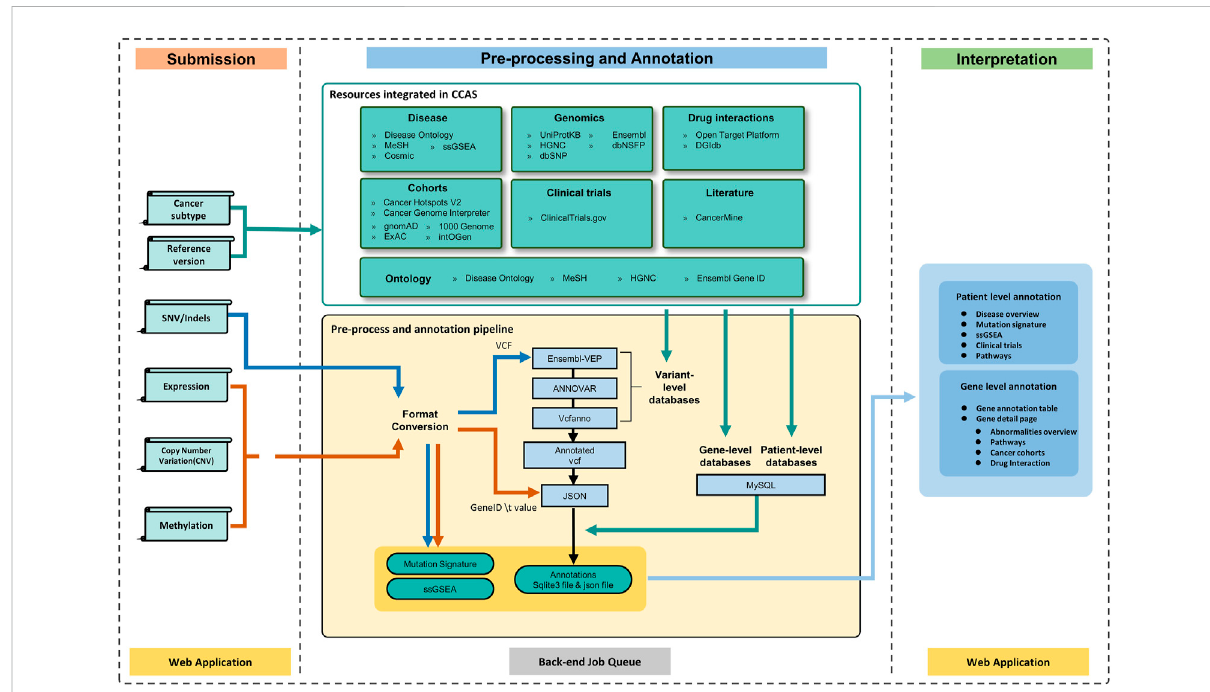
FIGURE 1 The work fl ow of CCAS can be divided into three modules: Submission, Pre-processing and Annotation, and Interpretation. After the user submits data to CCAS, CCAS fi rst converts the format of the fi les. SNV/Indels data will be converted to VCF format and other data types will be converted to “ Gene ID \t Value ” format. CCAS will then annotate the patient data using the integrated data sources at multiple levels. Mutation Signature and ssGSEA calculations are also performed. The annotation results are stored in sqlite3 database (a single fi le database) and json fi le. CCAS has built user-friendly interface to help users navigate and interpret the annotation results, enabling ef fi cient identi fi cation of key functional genes at the individual patient